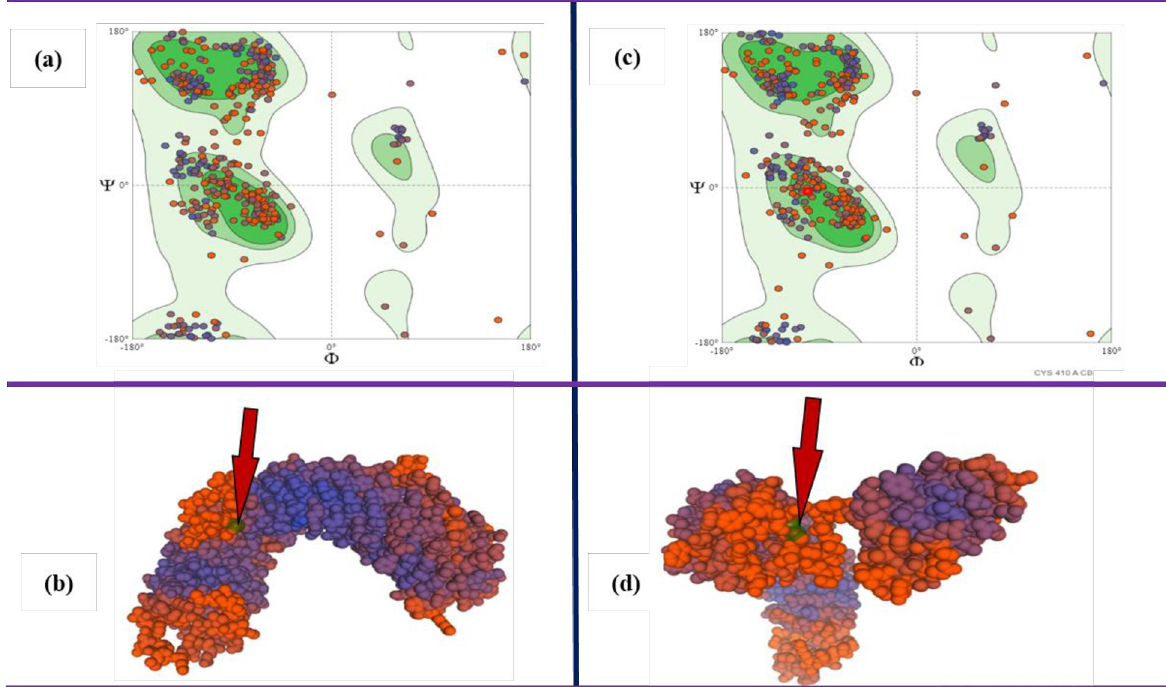
Fig 3. Ramachandran plot and proposed model for fea2 gene for high (AI 536) and Low (AI 535) KRN trait. (a) & (b) Ramchandran plot and proposed protein model of feq2 gene with a sequence identity fo 29.94% with template LRR receptor-like serine/threonine-protein kinase for Low KRN (AI 535), (c) & (d) Ramchandran plot and proposed protein model of fea2 gene with a sequence identity of 30.53% with template LRR receptor-like serine/threonine-protein kinase for Low KRN (AI